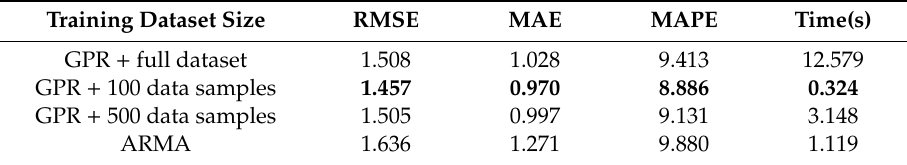
Table 3. Comparison of the proposed models built with two datasets in Y(3) prediction.